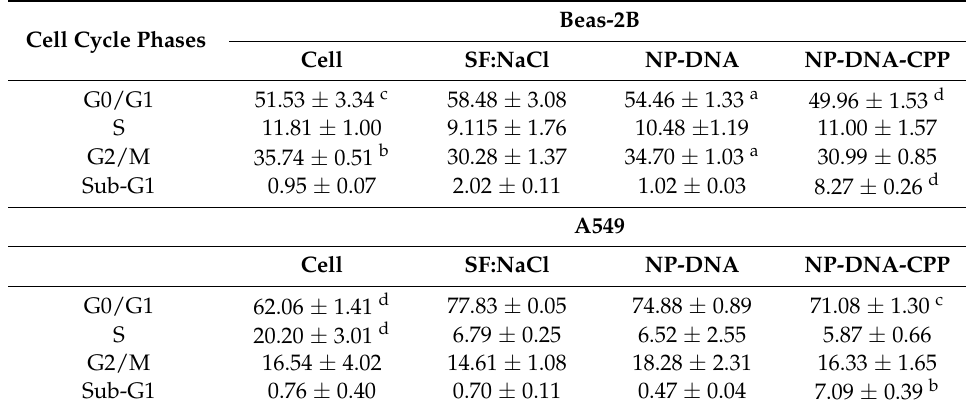
Table 2. Percentage of Beas-2B and A549 cells in each cell cycle phase (G0/G1, S, G2/M) analysed using propidium iodide by flow cytometry after exposure to NPs–DNA coated with or without CPP. Cell Cycle